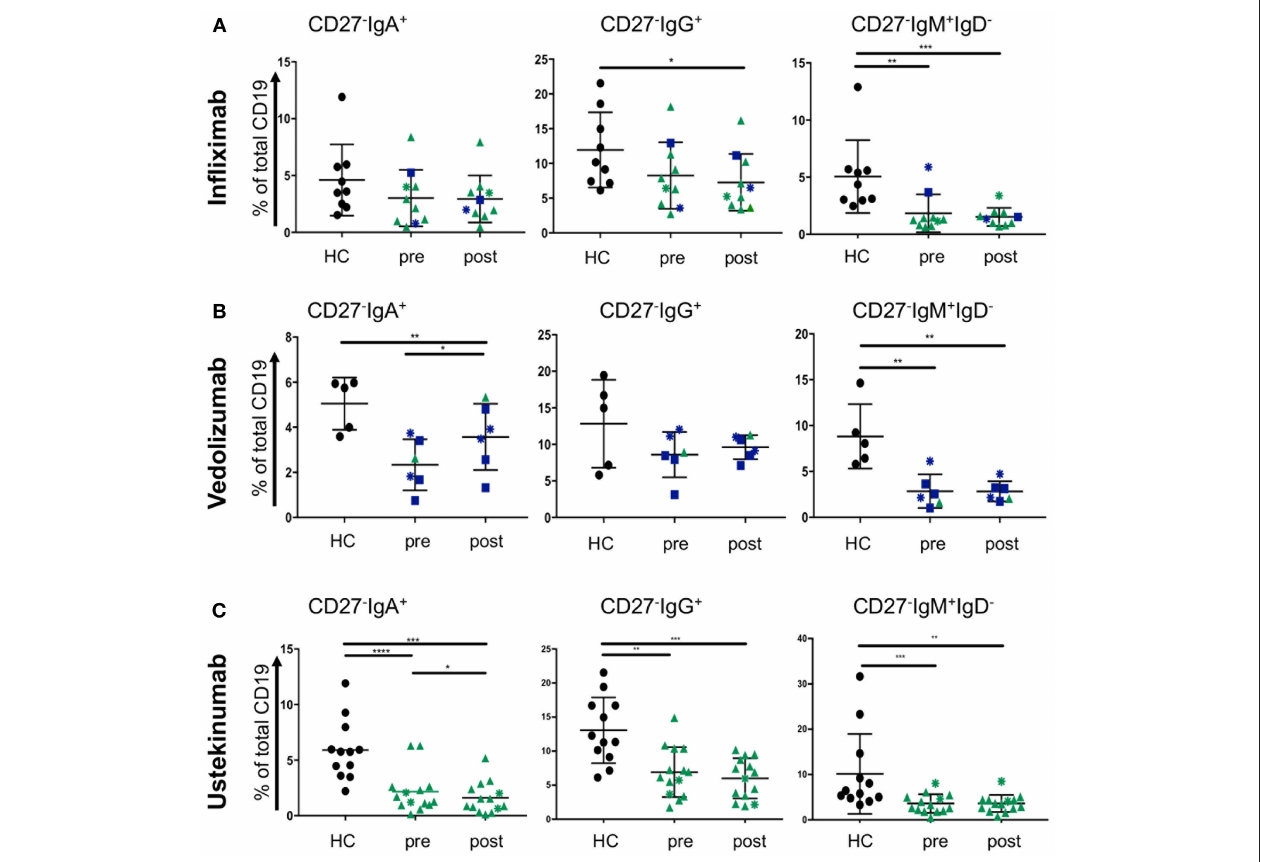
FIGURE 5 | CD27 − IgD − B cells subsets in blood of CD and UC patients treated with biologics. Patients were treated with either (A) infliximab ( n = 10, HC n = 9), (B) vedolizumab ( n = 6, HC n = 5), or (C) ustekinumab ( n = 14, HC n = 12) with a baseline (pre) and a post-treatment (6 weeks for infliximab and vedolizumab, and 8 weeks for ustekinumab) sample obtained. Subsets of CD27 − IgD − cells were compared to age and gender matched healthy controls (Dark blue squares: UC patients responsive to treatment; Dark blue asterisks: UC patients non-responsive to treatment; Green triangles: CD patients responsive to treatment; Green asterisks: